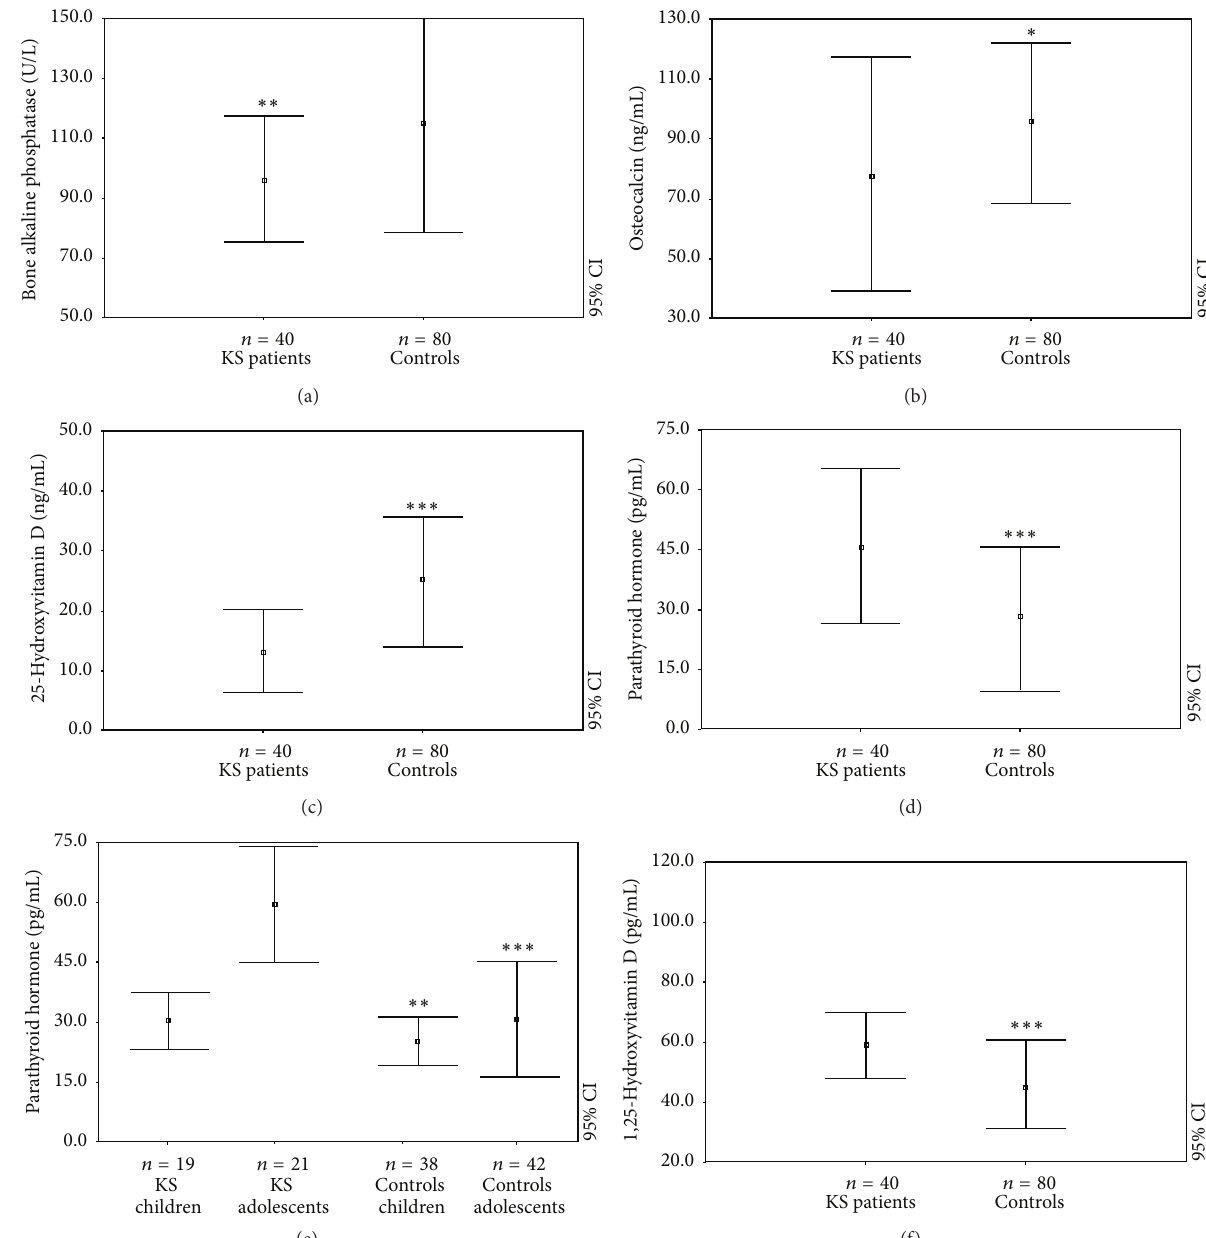
Figure 3: Bone alkaline phosphatase levels (a), osteocalcin serum levels (b), 25-hydroxyvitamin D levels (c), parathyroid hormone levels in total (d) and classified by age (as children and adolescents) (e), and 1,25-hydroxyvitamin D levels (f) in KS patients and controls. ∗ 𝑝 < 0.05 ; ∗∗ 𝑝 < 0.005 ; ∗∗∗ 𝑝 < 0.0005 .